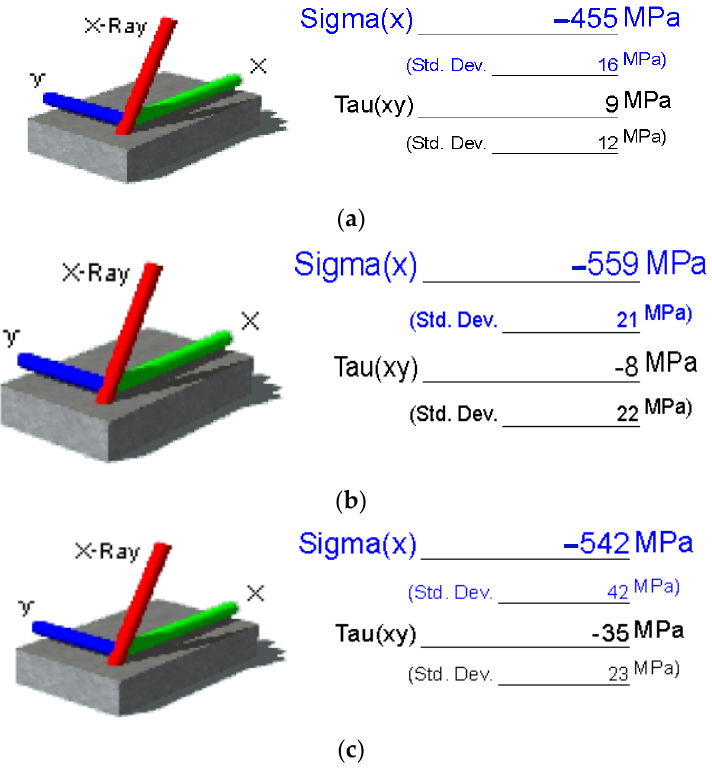
Figure 16. Residual stresses measurement for laser powers of ( a ) 600 W, ( b ) 700 W, and ( c ) 900 W. It is observed that the absolute value of the shear stress was far less than that of the normal stress. In Table 4, the numerical results of the normal stresses are listed for the experimental measurement and the simulation. According to the results, the experimental results had good consistency with the ones of the simulation, and the maximum deviation of the normal stresses was 10.5% when the laser power was 600 W. Table 4. Comparison of residual normal stresses with different laser powers.